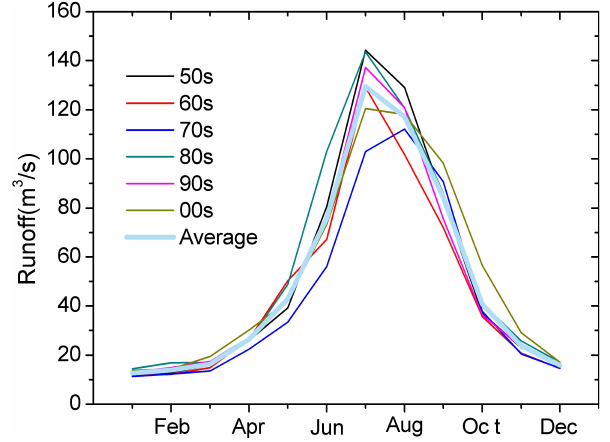
Fig. 7. Average monthly runoff change of YingLuoXia station from 1950s to present.